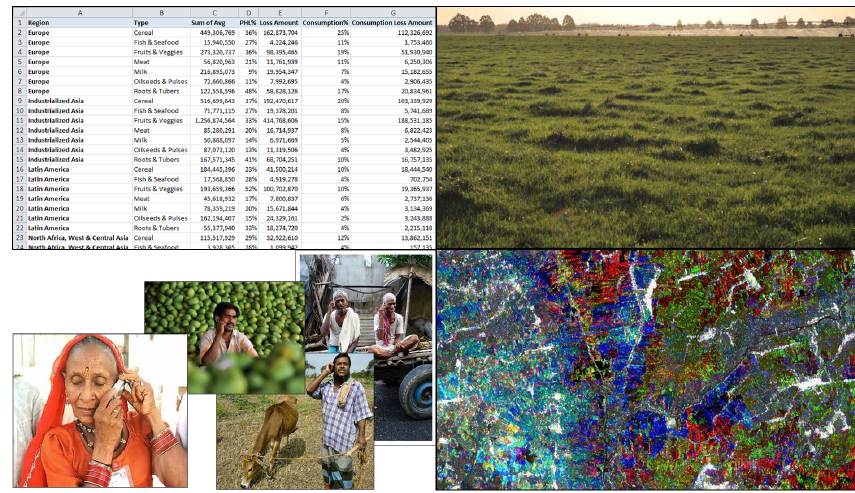
Fig. 6. A few sources of